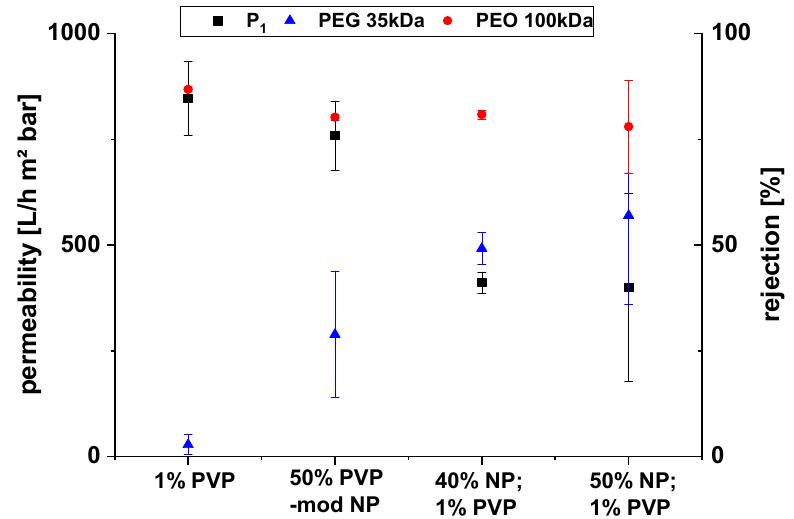
Figure 8. Separation performance comparison for PVDF membranes obtained with PVP-modified ZnO nanoparticles with membranes prepared from dope solutions with same PVP content but no ZnO (“1% PVP”), as well as dope solutions containing either 40% or 50% pristine ZnO and 1% PVP.